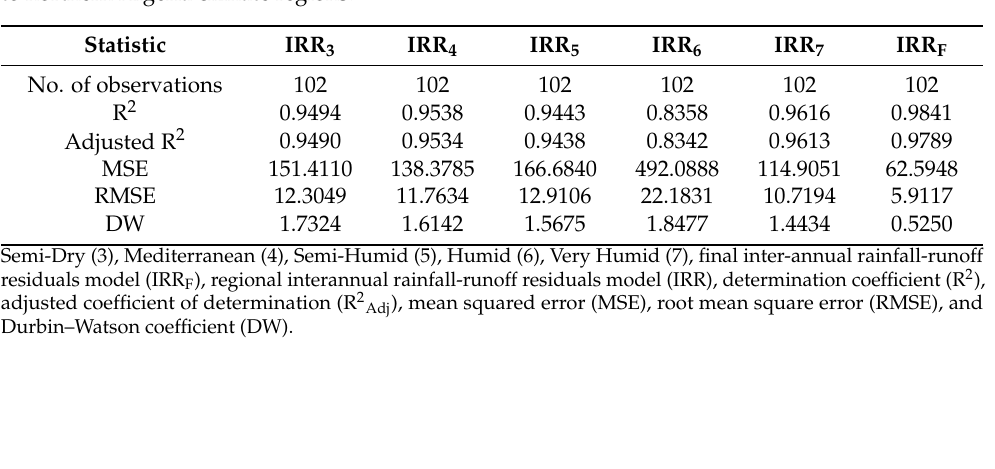
Table 6. Performance tests of final and regional inter-annual rainfall-runoff residual models applied to northern Algeria climate